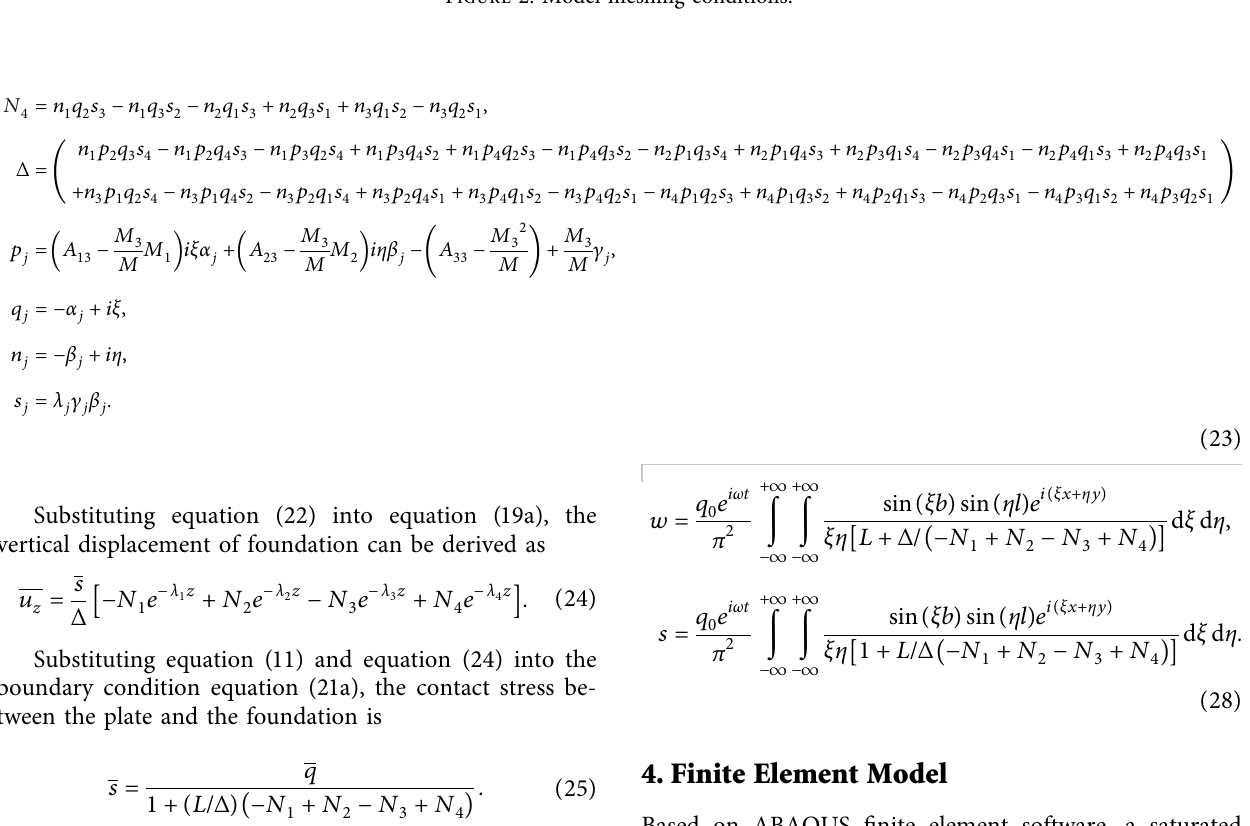
Figure 2: Model meshing